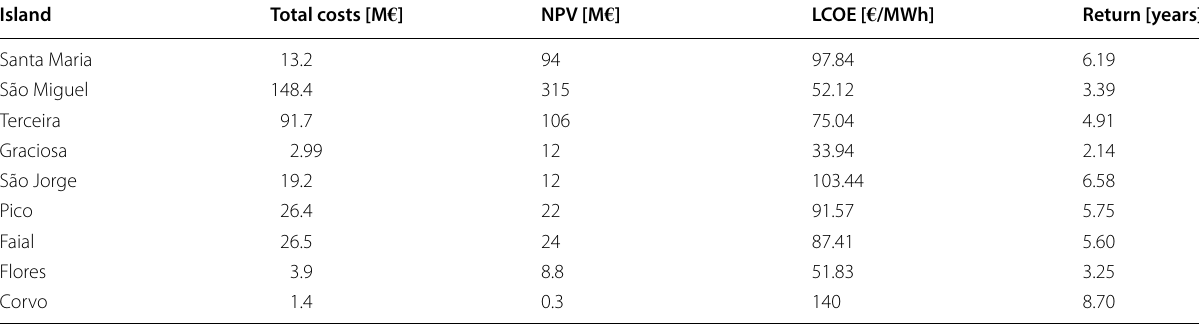
Table 21 Summary of data evaluating the investment made on each island for the first solution Island